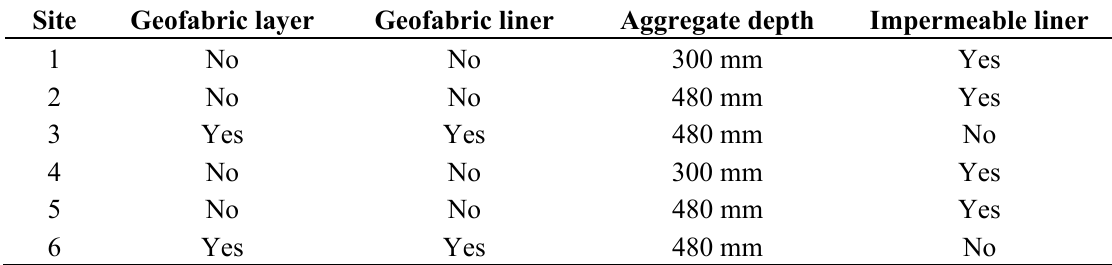
Table 1. Range of different construction techniques used across sites.